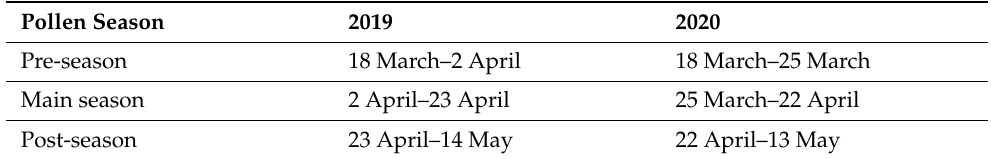
Table 1. Classification of pollen seasons for the seed plantation Schorndorf in 2019 and 2020. Pollen